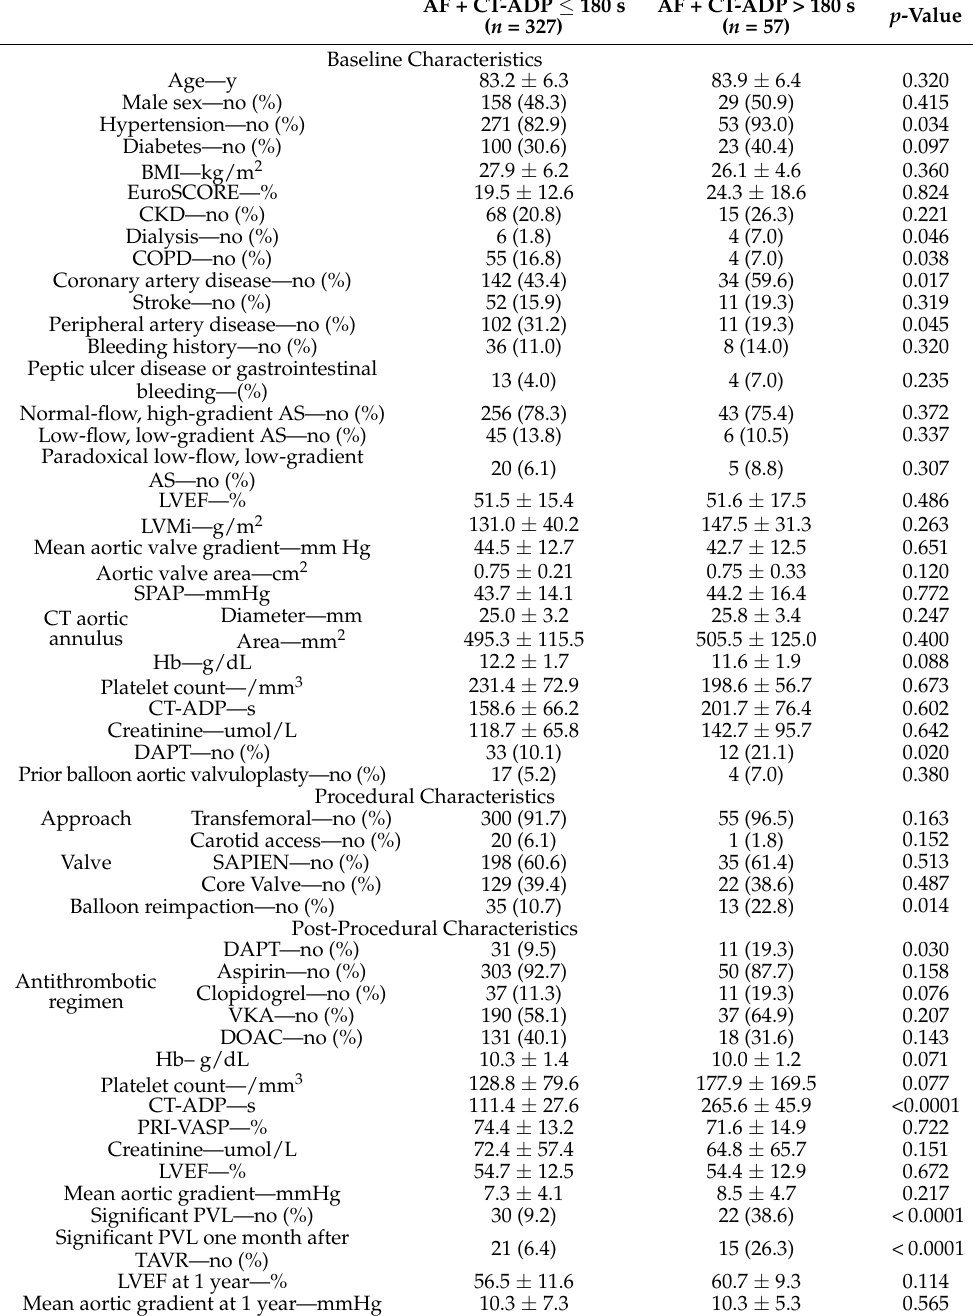
Table 1. Baseline, procedural, post-procedural, and biological